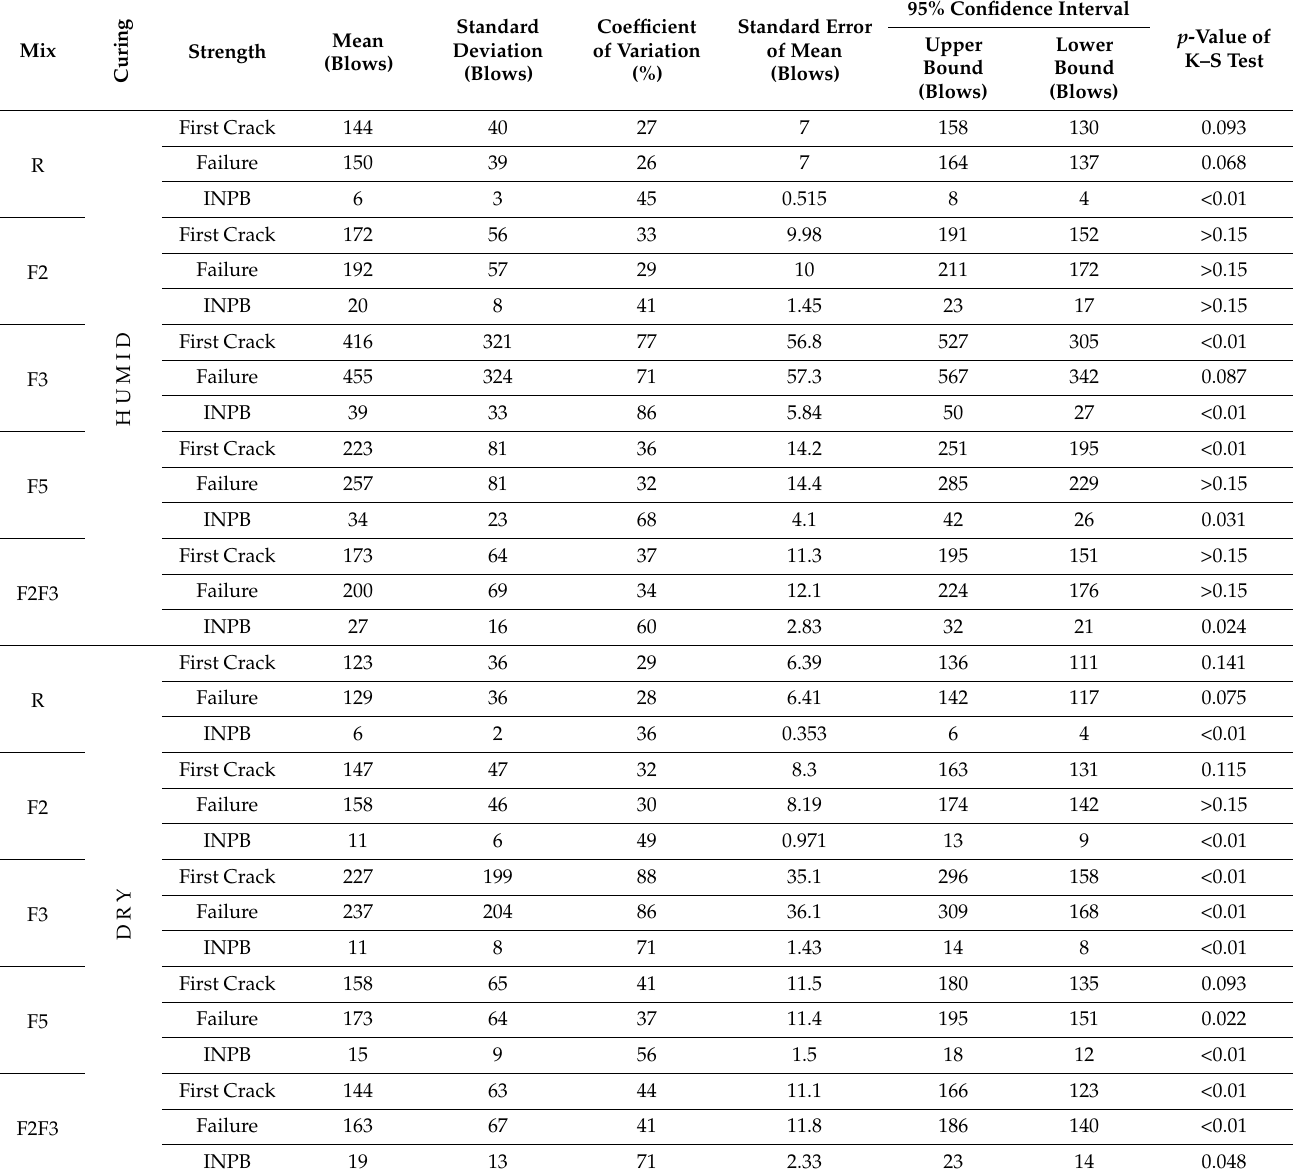
Table 8. Statistical variables for initial crack strength, fracture strength, and